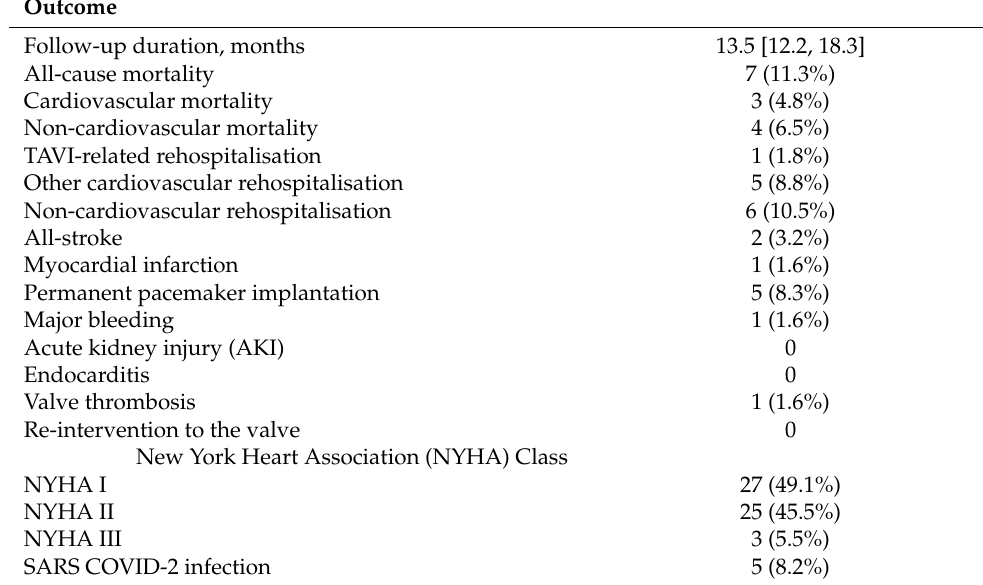
Table 2. Clinical outcomes during follow-up.